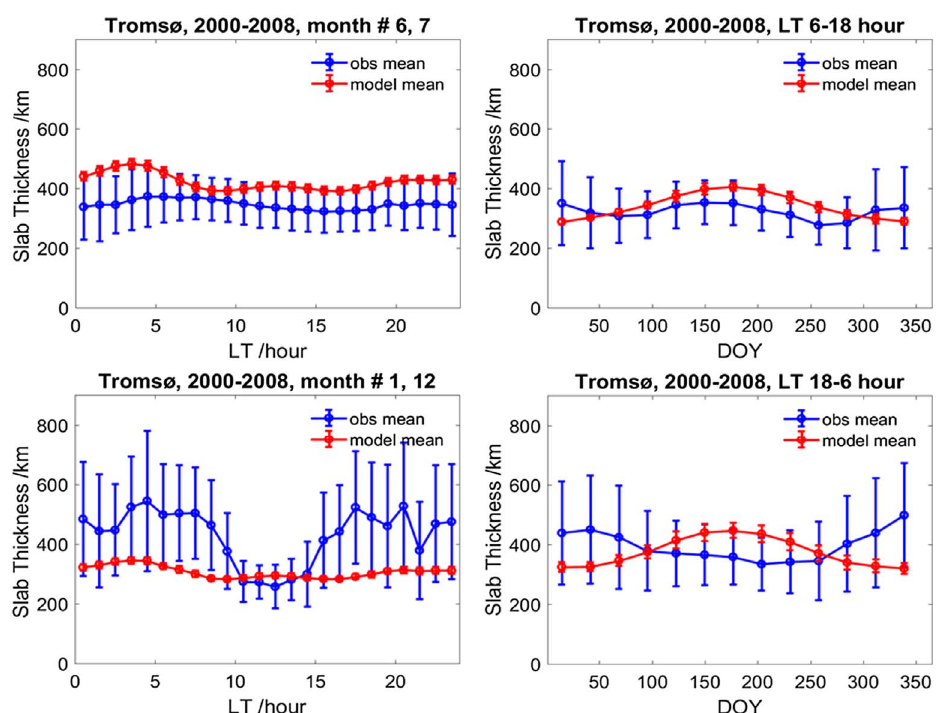
Fig. 9. Diurnal and seasonal variation of the observed and modelled s over Tromsø for summer (June/July) and winter (December/January) conditions and for day (6 – 18 LT) and nighttime (18 – 6 LT) conditions, respectively.